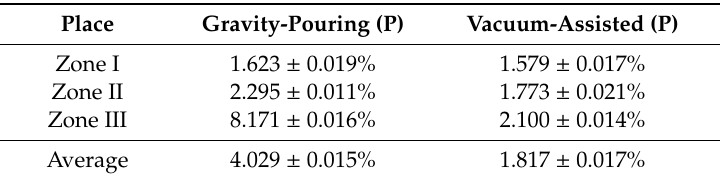
Table 5. Volumetric porosity in the di ff erent zones of the